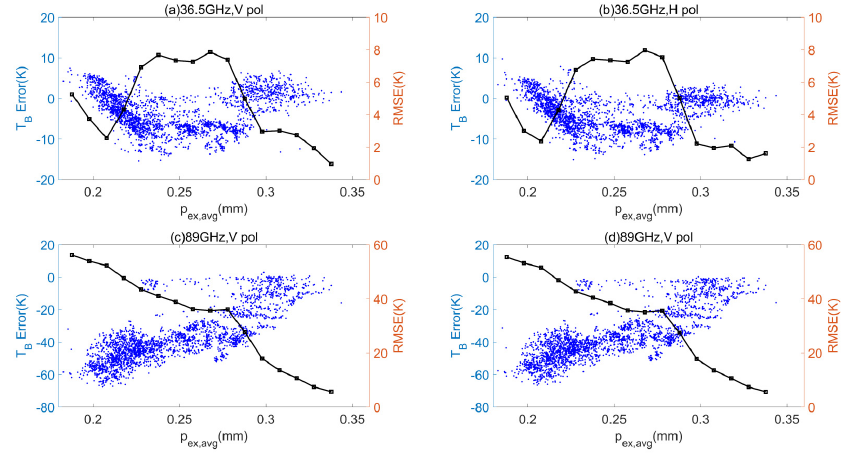
Figure 12. Sensitivity of brightness temperature (T B ) Error to mass-weighted average exponential correlation length ( p ex,avg ) at 55° incidence angle: ( a ) 36.5 GHz, V pol.; ( b ) 36.5 GHz, H pol.; ( c ) 89 GHz, V pol.; and ( d ) 89 GHz, H pol. The blue scatter points are T B Error of different samples. The black line is the T B RMSE summarized at 0.01 mm p ex,avg step. It was calculated using samples +/–0.005 mm around each p ex,avg step.